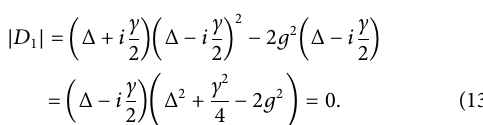
. The other parameters are similar to those in Figure 4